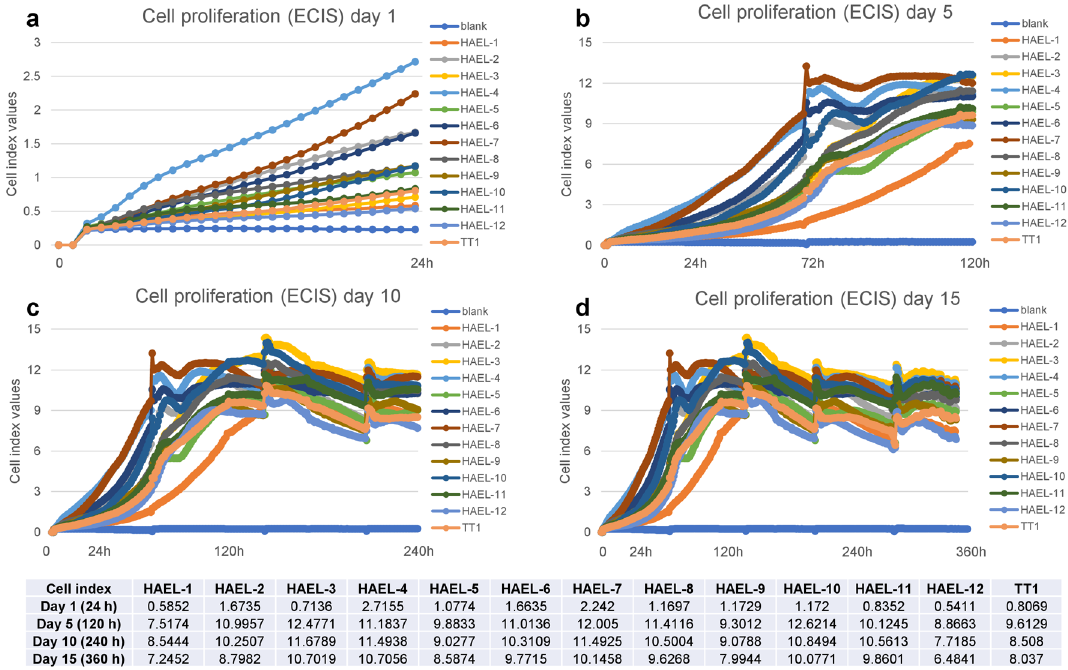
Figure 7. Cell proliferation given as cell index of ICs and TT1 cells after 1 ( a ), 5 ( b ), 10 ( c ) and 15 ( d ) days (media changed every 3